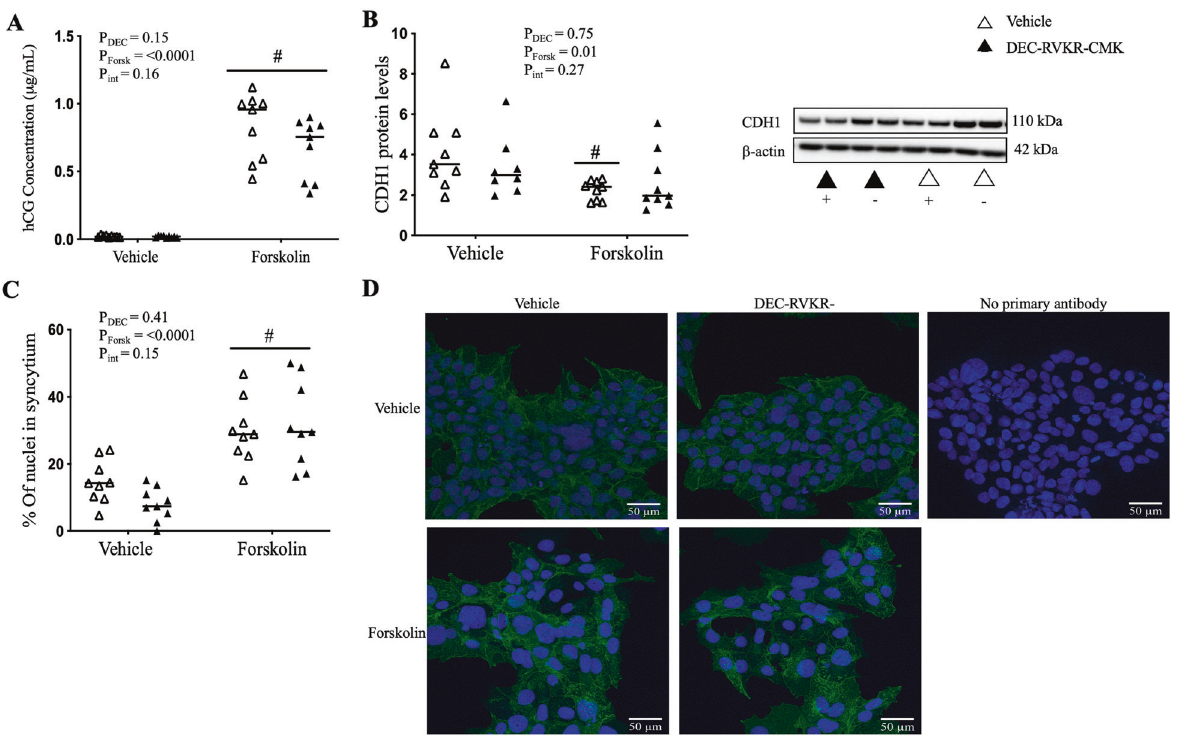
Fig. 4 DEC-RVKR-CMK had no effect on forskolin-induced syncytialisation of BeWo choriocarcinoma cells. BeWo cells were simultaneously treated with DEC-RVKR-CMK and forskolin and left to syncytialise. Forskolin treatment successfully induced syncytialisation, this is depicted by increased ( A ) hCG secretion, decreased ( B ) E-cadherin (CDH1) protein levels and increased ( C ) percent of nuclei in syncytia (as determined by CDH1 immunostaining). DEC-RVKR-CMK treatment had no effect on ( A ) hCG secretion, ( B ) E-cadherin (CDH1) protein levels or ( C ) the percent of nuclei in syncytia (as determined by CDH1 immunostaining), respectively. Representative images in ( D ) depict cells stained for CDH1 (green) and counterstained with DAPI (blue). No primary antibody control images omitting the primary antibody are included, controlling for non- speci fi c secondary antibody binding. Representative blots are shown where β -actin was used as a loading control. # Denotes signi fi cant difference to the forskolin vehicle control. Data are presented as the median with effects of Forskolin (P Forsk ), DEC-RVKR-CMK (P DEC ) or the interaction between these parameters (P Int ) noted. N = 3 experiments in triplicate. For immunocytochemistry only: N = 3 in singlicate (three